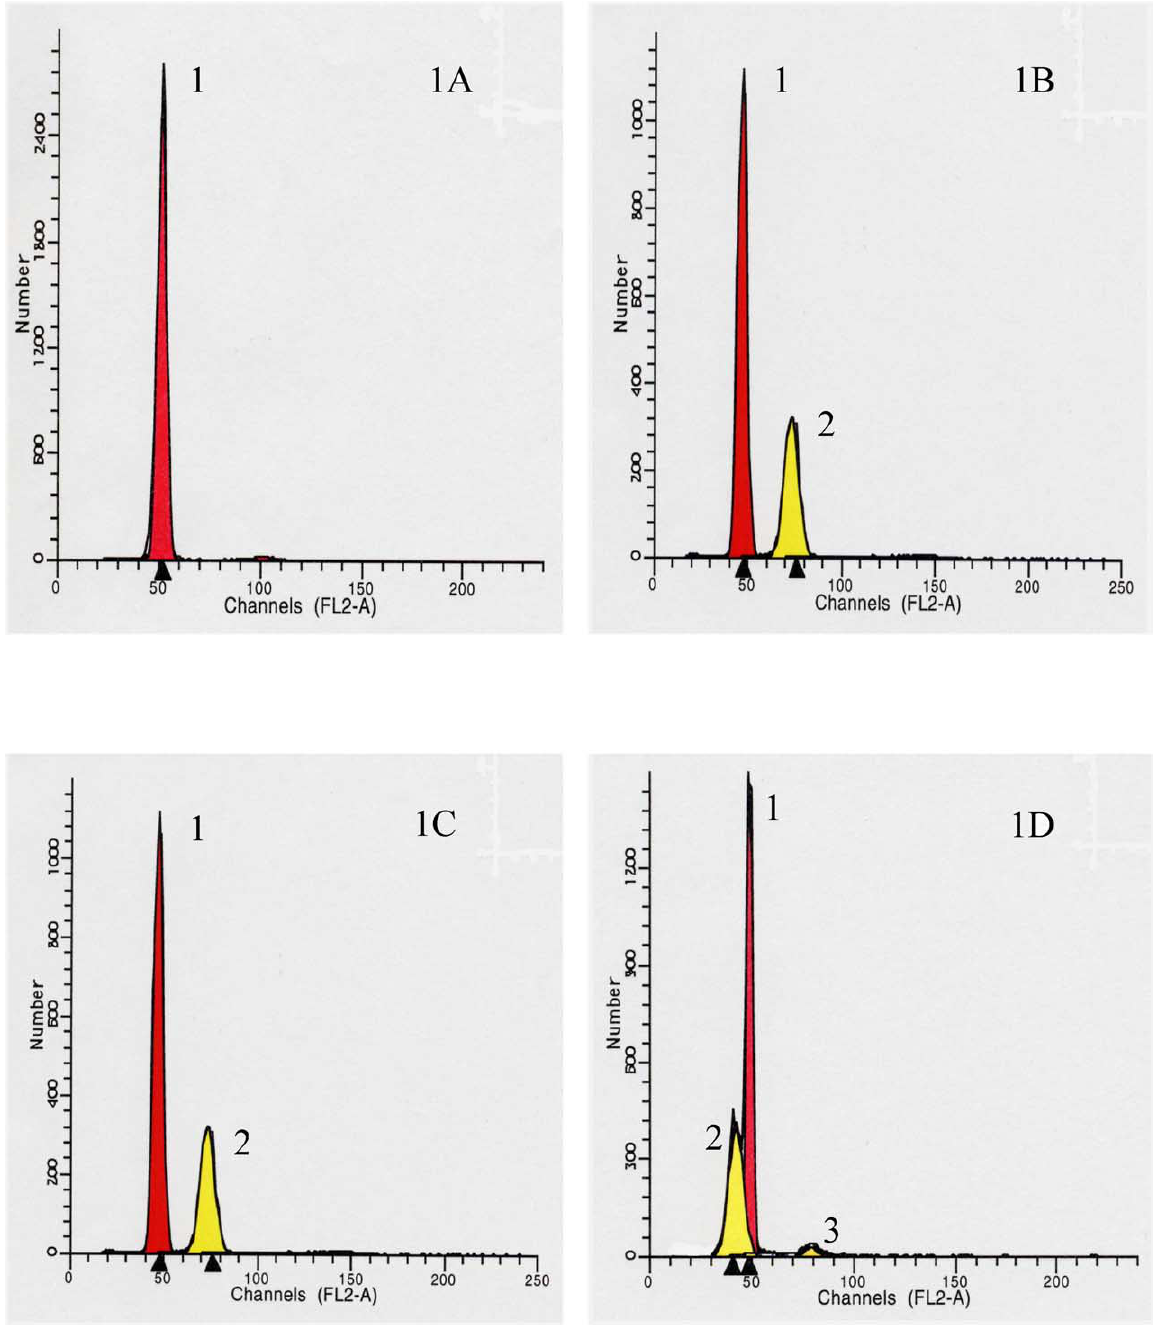
Fig. 1. Examples of DNA content in renal tumors. The vertical axis indicates the number of nuclei analyzed; the horizontal axis indicates the DNA fluorescence. Peak 1 is the diploid reference of mixture of human lmyphocytes. 1A is an oncocytoma: DNA index = 1, CV = 3.3%. 1B is a clear cell RCC: DNA index of the peak 2 = 1.55, CV = 3.2%. 1C is a papillary RCC: DNA index of the peak 2 = 1.56, CV = 5.0%. 1D is a chromophobe RCC: DNA index of peak 2 = 0.84, CV of peak 2 = 4.8%; DNA index of peak 3 = 1.73, CV of peak 3 =